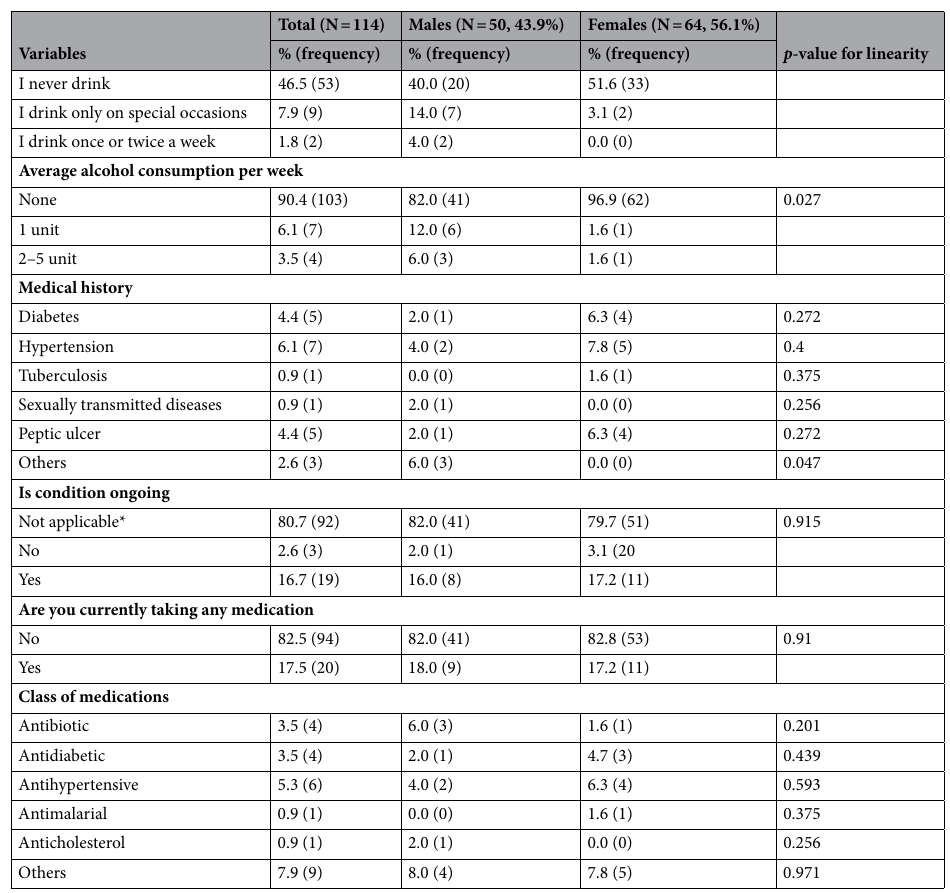
Table 1. Description of the sample. *Under age; %, percentage frequency. ‡ Northerner is a collective name for all ethnic group in the northern region of